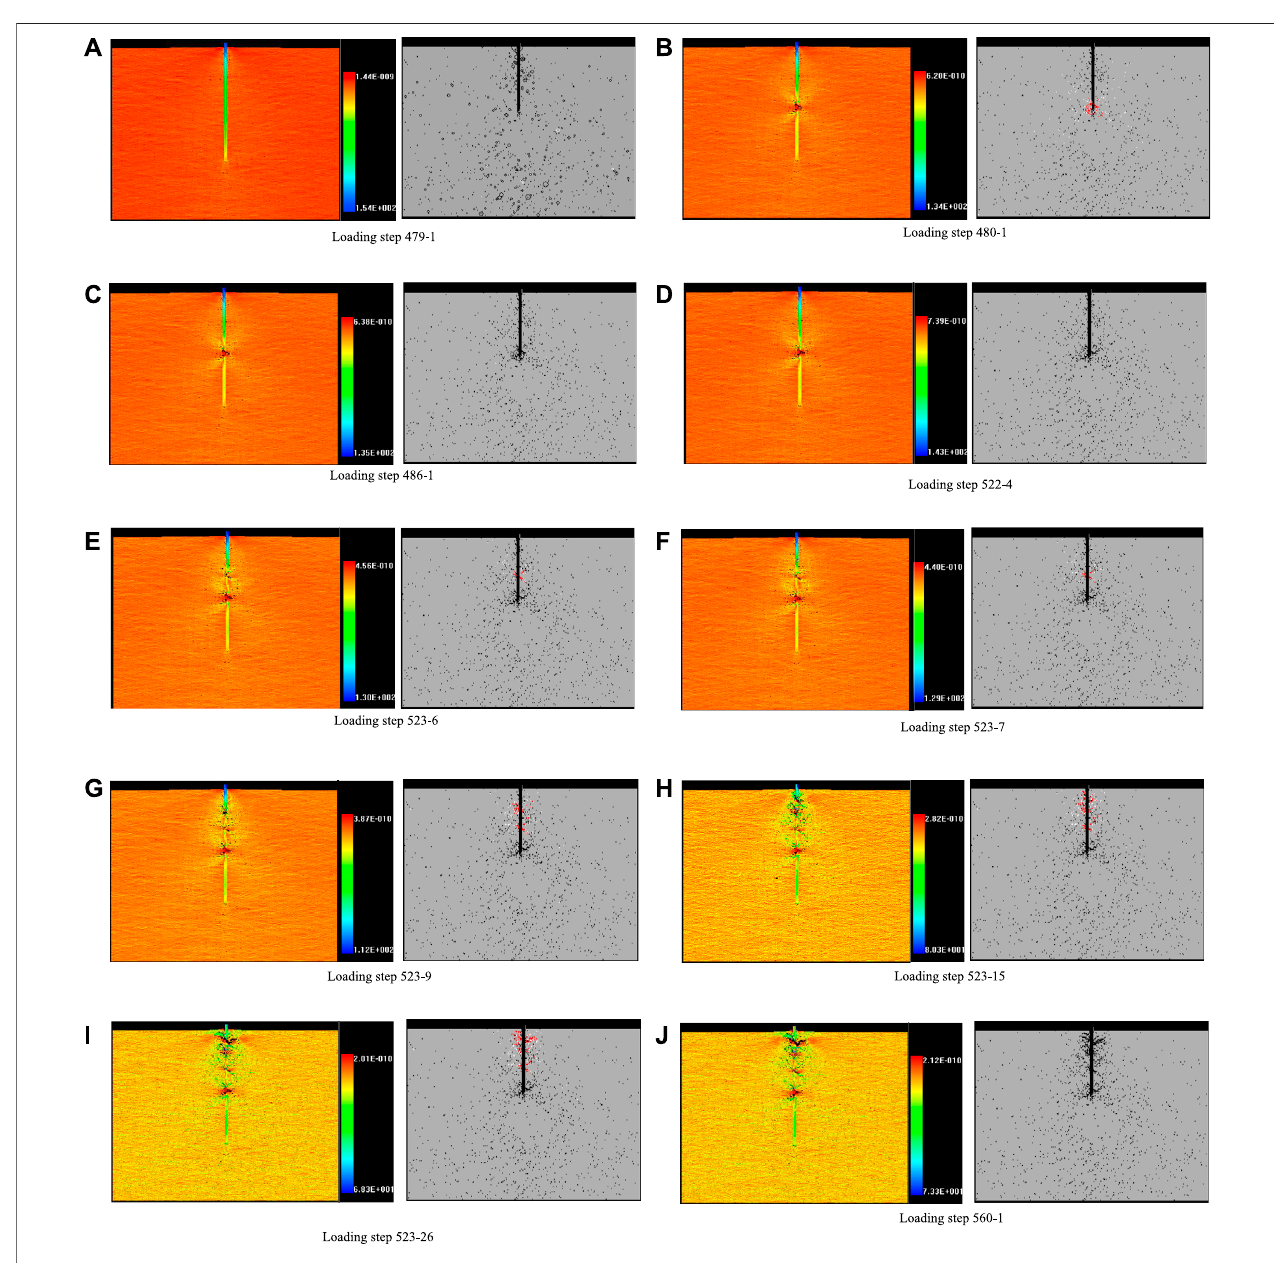
FIGURE8| FailureprocessofanchoredrockwiththenegativePoisson ’ sratiobolt(theleftcolumnistheminimumprincipalstressnephogram,andtherightcolumn istheacousticemissiondiagram). (A) Loadingstep479-1. (B) Loadingstep480-1. (C) Loadingstep486-1. (D) Loadingstep522-4. (E) Loadingstep523-6. (F) Loading step 523-7. (G) Loading step 523-9. (H) Loading step 523-15. (I) Loading step 523-26. (J) Loading step